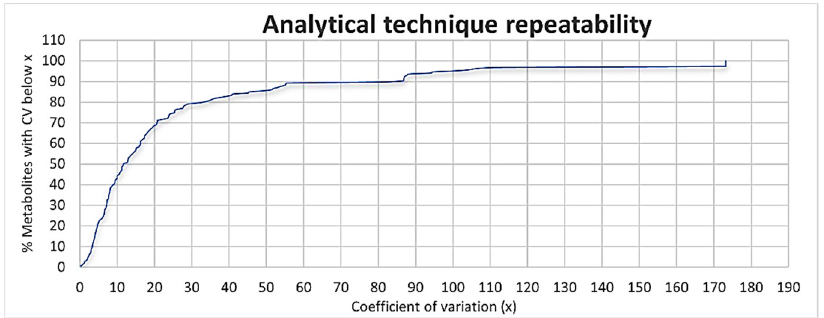
Figure 1. Distribution of the coefficients of variation values for technical repeatability.